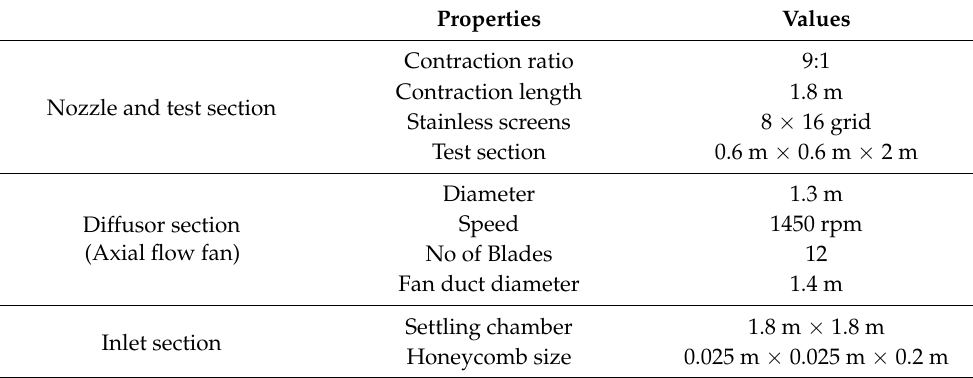
Table 16. Drag for various speeds.